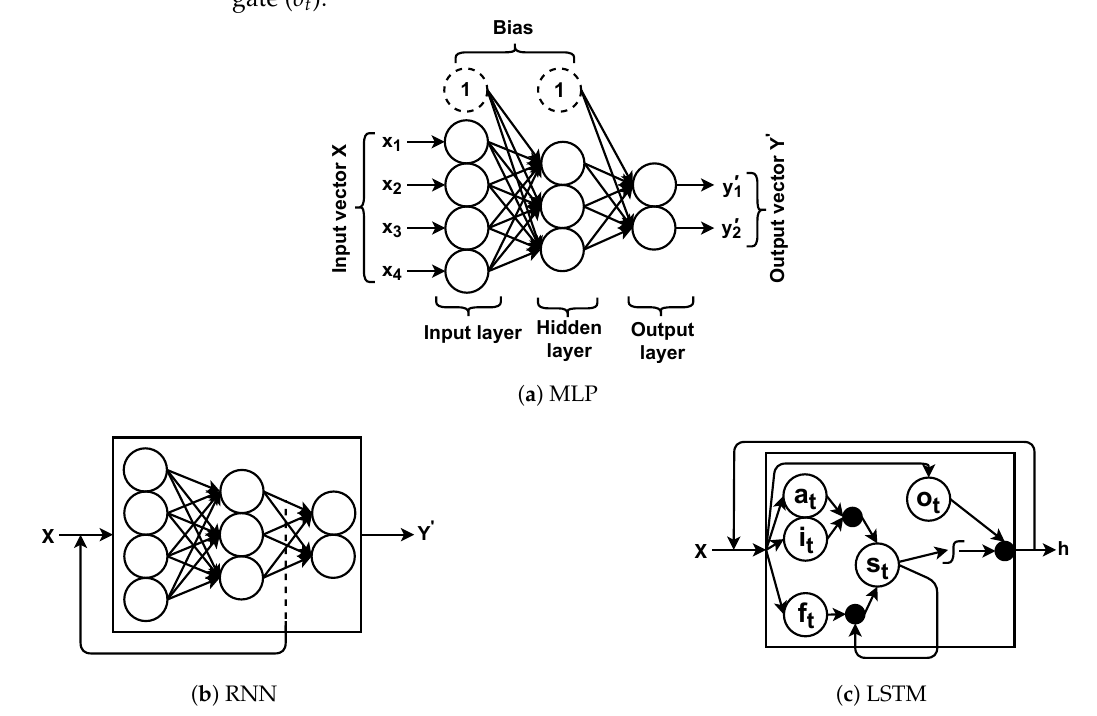
Figure 3. ANN types. ( a ) A three-layer feed-forward network that takes inputs and produces two outputs. ( b ) RNN neural network in which the hidden layer output returns to the network. ( c ) LSTM cell with four gates in which • is Hadamard (cid:82) product and is the activation